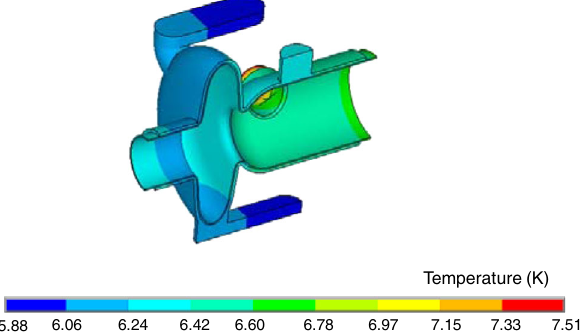
FIG. 15. Temperature distribution along the cavity surface.